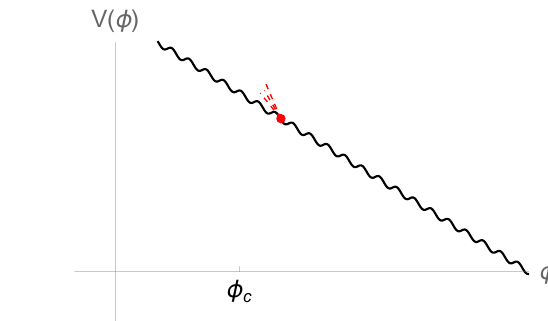
= − M/(cid:15) , trapping the c